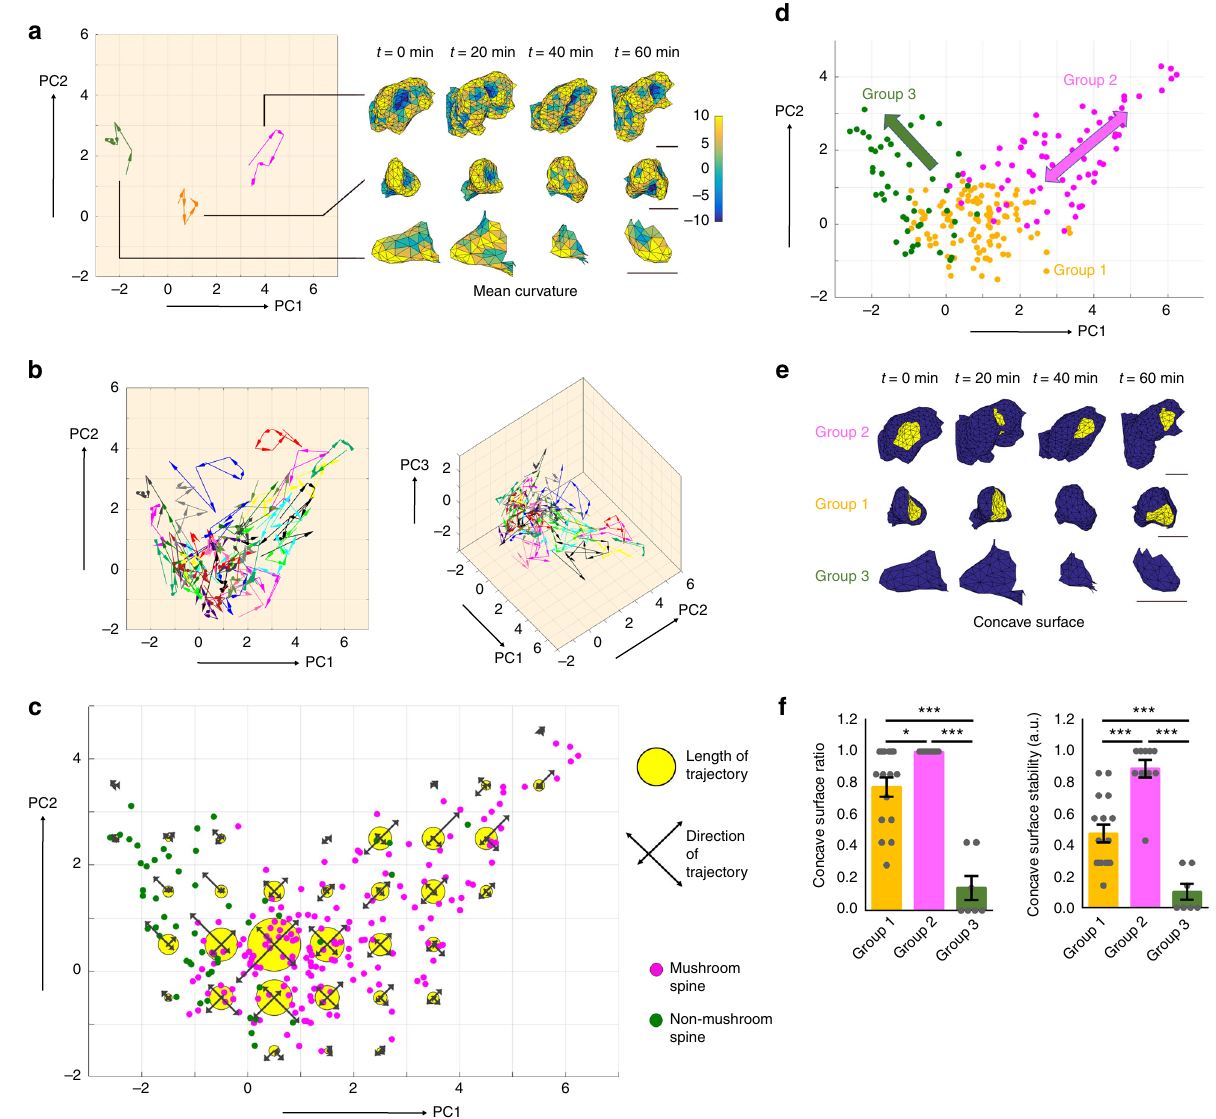
Fig. 3 Spine shape transition studied by SIM-based geometrical analysis. a Trajectories of shape transition for three examples of spines mapped into the feature space. The right images of reconstructed spine shapes are from three spines at multiple time points (0 – 60 min). The values of mean curvatures are mapped onto the surface. Bar: 500 nm. b Projection and 3D maps of trajectories created from a population of spines (46 spines from eight neurons in fi ve independent culture preparations). c The direction and length of trajectories in spine shape changes, mapped into the feature space. Total lengths of trajectories are shown as the radii of yellow circles, and trajectories projected onto four orthogonal directions are shown as black arrows. The PC1 – 2 plane is shown. The positions of spines at different time points were also mapped after SVM-based shape classi fi cation into mushroom and non-mushroom spines (magenta and green dots). d A scheme of three types of spine behavior in the feature space. Orange, magenta, and green dots indicate spines classi fi ed in groups 1, 2, and 3, respectively. e Mapping of the most concave surface on spine heads classi fi ed in groups 1, 2, and 3. Group 2 spines maintained the concave surface, whereas the concave surface was less stable in group 1, and did not exist in group 3. f The fraction of time points when the concave surfaces can be mapped to spine heads (concave surface ratio), and the fraction of time points when the concave surfaces located in the same direction within the spine heads (concave surface stability) were measured for three groups of spines [ n = 16, 10, and 7 spines for groups 1, 2, and 3, respectively; one-way ANOVA followed by Tukey – Kramer procedures for multiple comparison tests; concave surface ratio: F(2,30) = 41.57, p = 2.25 × 10 − 9 ; concave surface stability: F(2,30) = 33.78, p = 2.08 × 10 − 8 ; * p < 0.05, *** p < 0.001. Data are presented as the mean ±